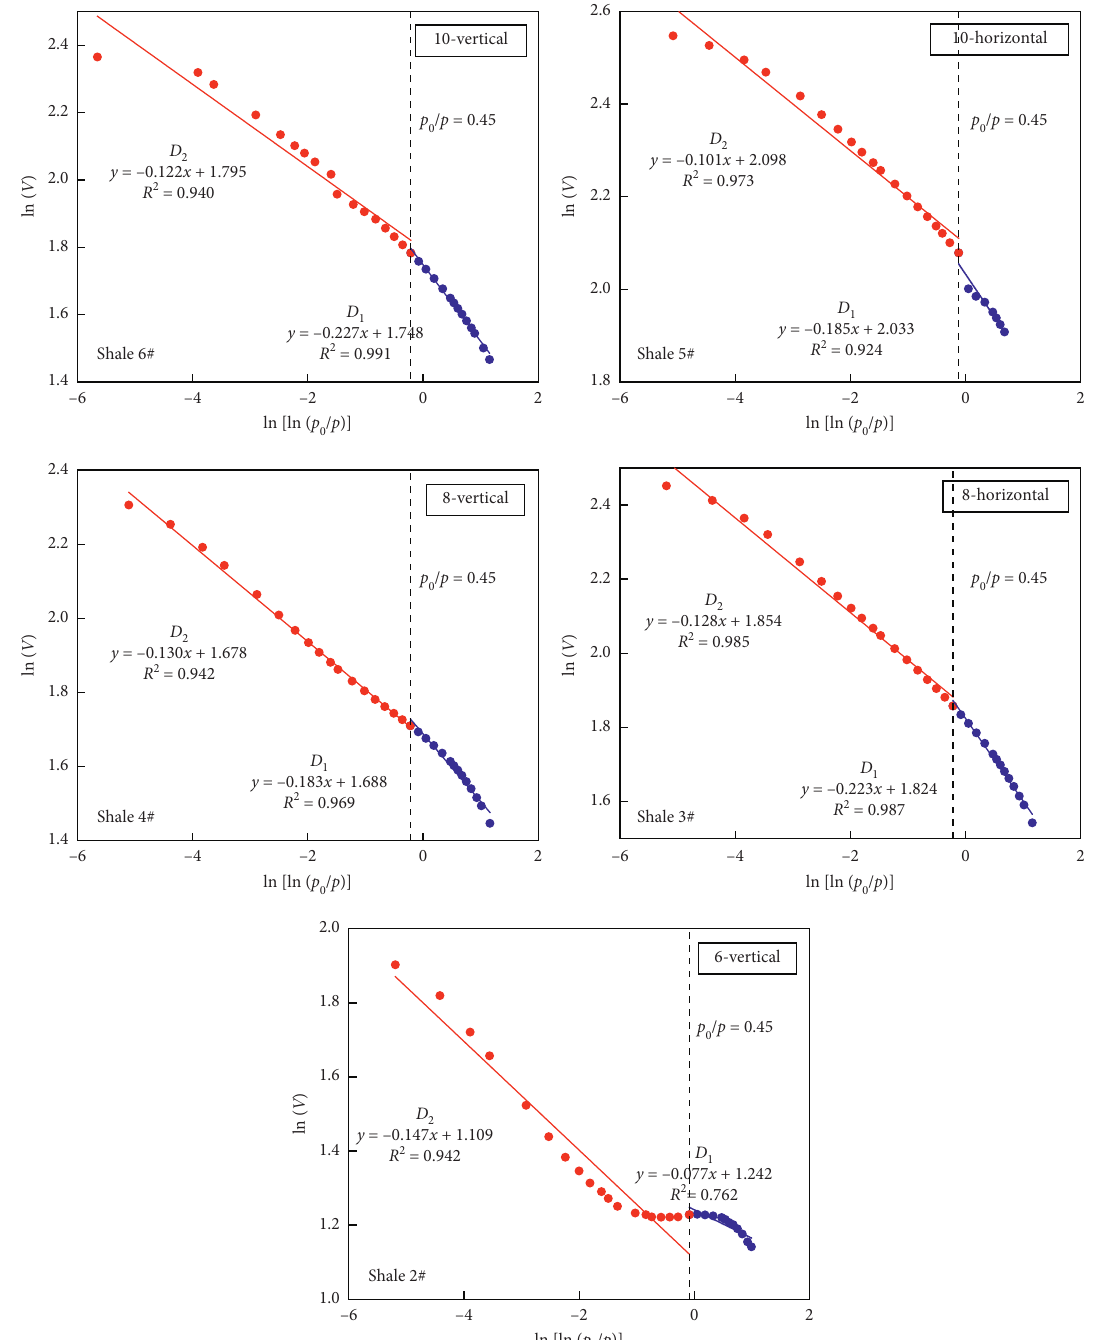
Figure 8: Double logarithm curves of adsorption volume by low-temperature nitrogen